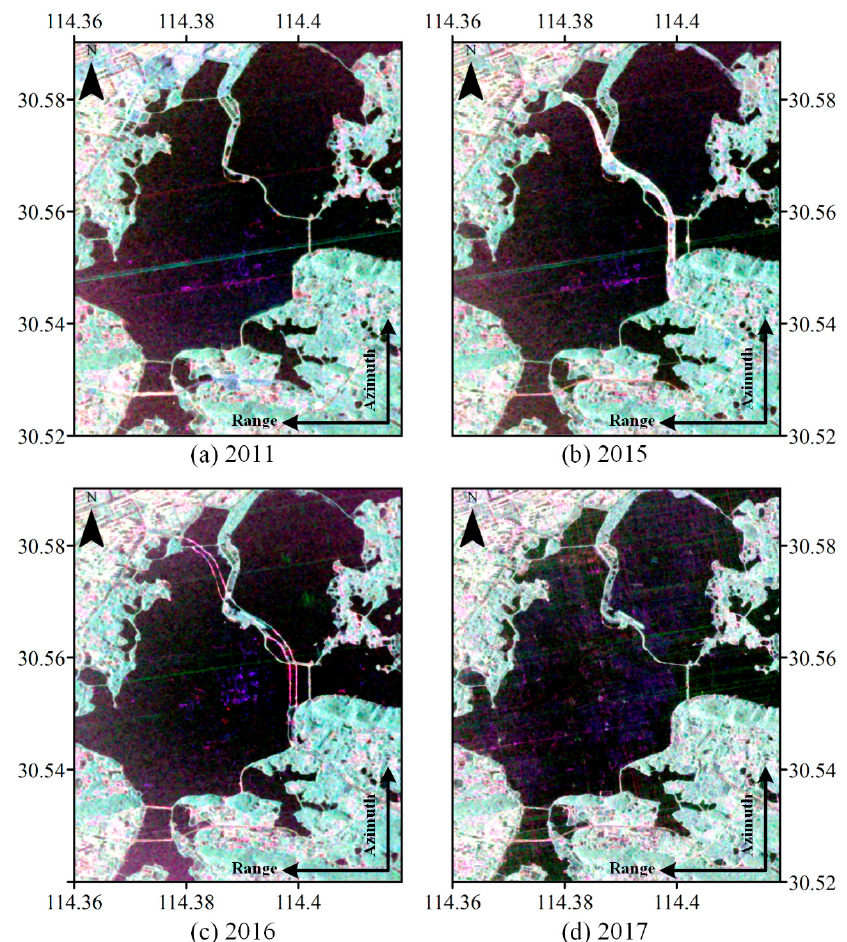
Figure 7. Pauli RGB images of the second group of time-series images, with red | S HH − S VV | 2 , green 4 | S HV | 2 , and blue | S HH + S VV | 2 . The image of 2011 is the source domain and the other images are the target domain. Table 3. Description of the second group of time-series images.